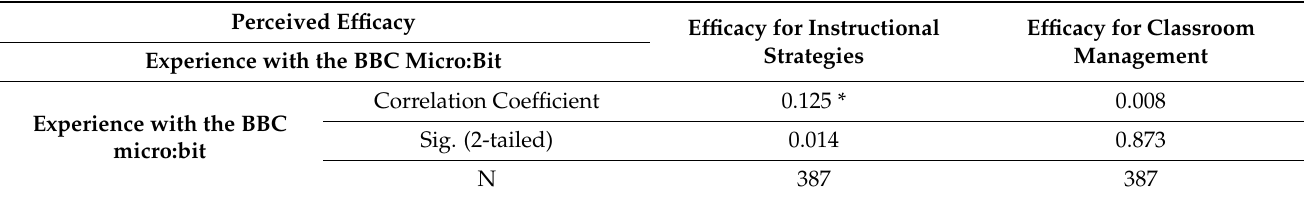
Table 6. T2 Relationship between the perceived efficacy of CS teachers and their experience with the BBC micro:bit.